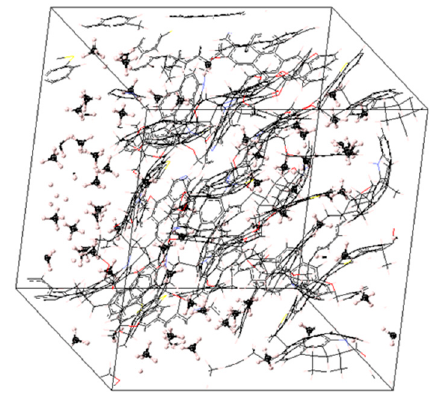
Figure 5. Sample realization of methane molecules adsorbed in II-D kerogen structure.